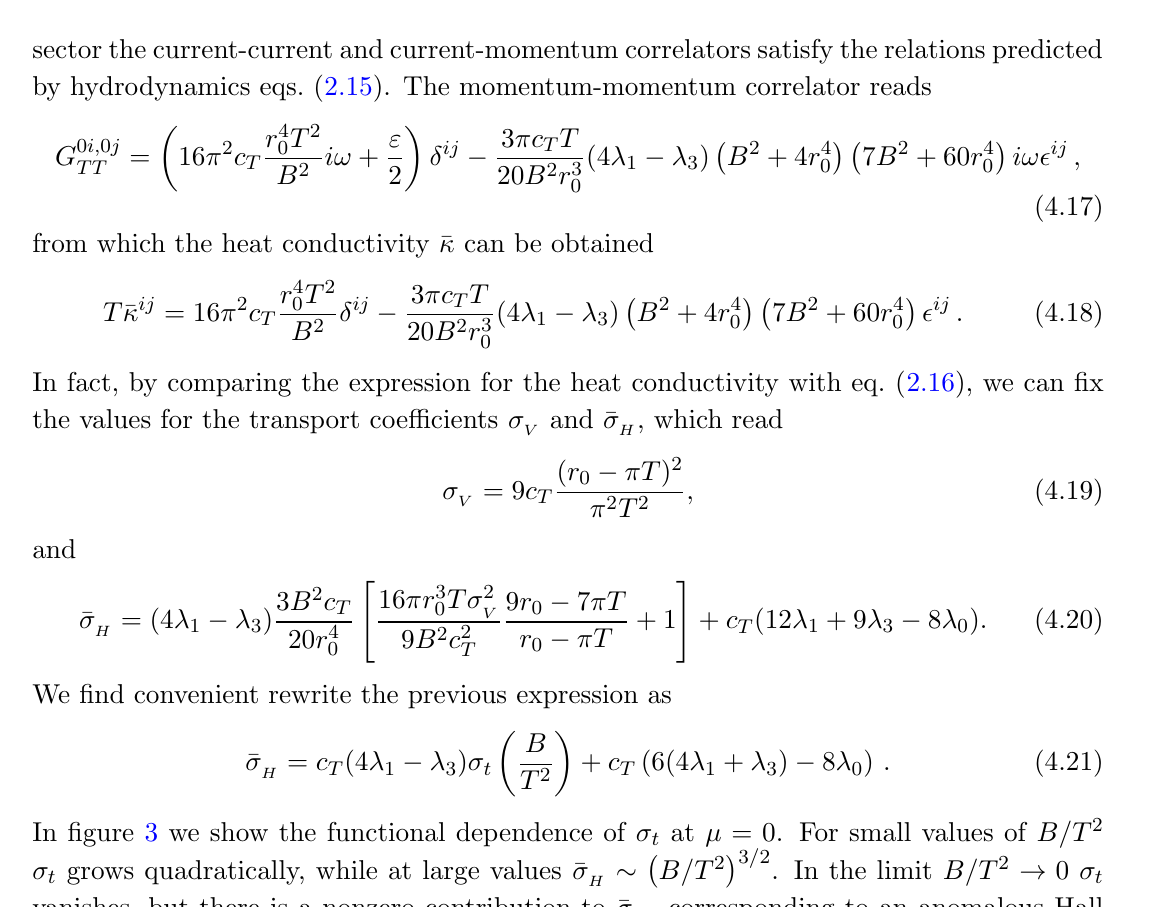
(cid:0) (cid:1) 3 = 2 B=T 2 .